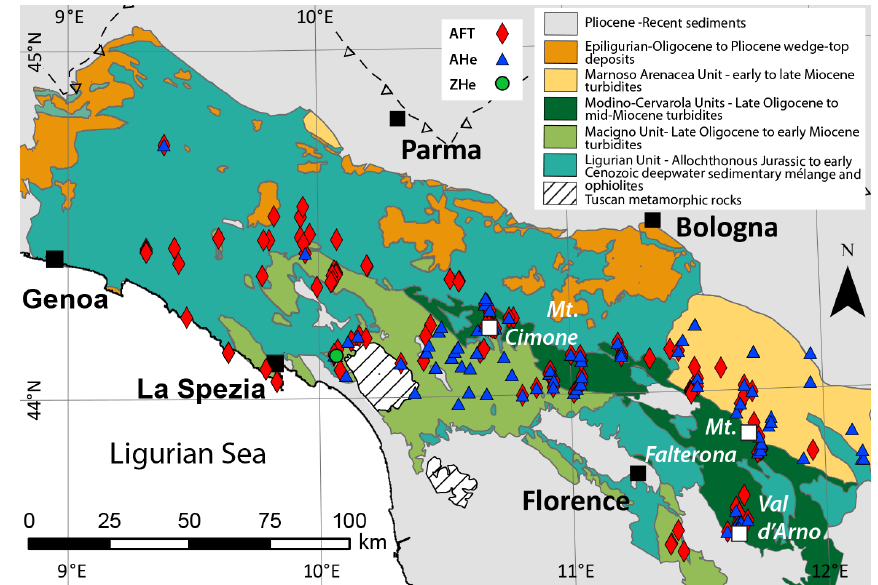
Figure 1. Simplified geologic map of the Northern Apennines and locations of published ( > 10Ma) bedrock AFT samples (diamonds) (Abbate et al., 1994; Balestrieri, 2000; Balestrieri et al., 1996, 2018; Bonini et al., 2013; Carlini et al., 2013; Fellin et al., 2007; Thomson et al., 2010; Ventura et al., 2001; Zattin et al., 2002), AHe samples (triangles) (Fellin et al., 2007; Thomson et al., 2010), and ZHe sample (circle) (Fellin et al., 2007). Dashed sawtooth lines represent the thrust front buried beneath Po Plain sediments. The following chronostratigraphic divisions are used as minimum depositional ages for the Cenozoic foredeep units: Macigno Unit (Chattian–Aquitanian) (Cita Sironi et al., 2006), Cervarola Unit (Aquitanian–Langhian) (Delfrati et al., 2002), and Marnoso–Arenacea Unit (Burdigalian–Tortonian) (Pialli et al.,